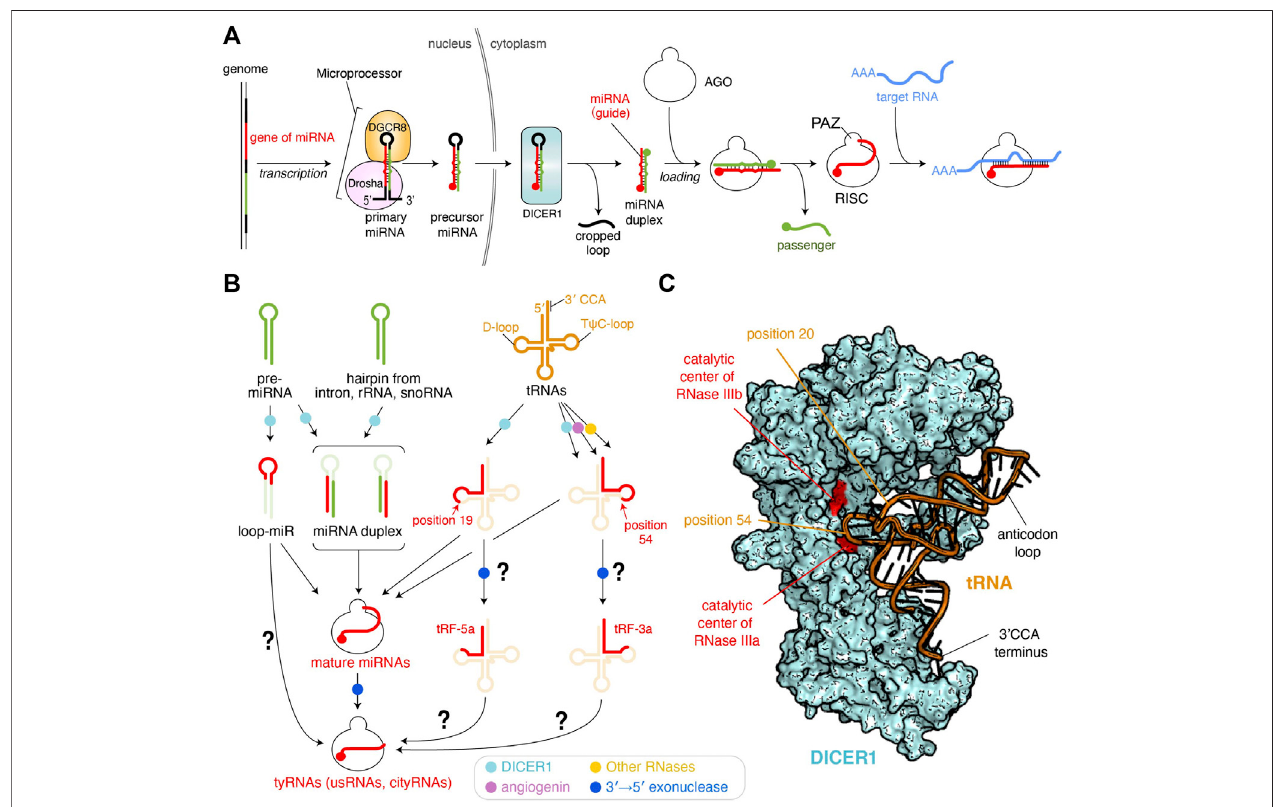
FIGURE1| BiogenesispathwaysofmiRNAsandtyRNAs. (A) CanonicalmiRNAbiogenesis.5 ′ monophosphategroupsaredepictedasspheres.Theschematicis modi fi ed basedon the fi gure intheprevious review(Nakanishi, 2016) (B) Biogenesis oftyRNAsderivedfrom miRNAs and otherRNAs. Enzymes involved inthepathway are shown as different colored dots. The pathways to be studied further are shown with a question mark. (C) Model oftRNA-docked onto human DICER1. The DICER1 structure of the original coordinates (PDB: 5ZAL) re fl ects an inactive form because the C-terminal double-stranded RNA-binding domain (dsRBD) interferes with binding of the double-stranded RNA to the RNase IIIa and IIIb. The dsRBD is moved away to make a slicer-active model. A tRNA (PDB ID: 1EHZ) is manually